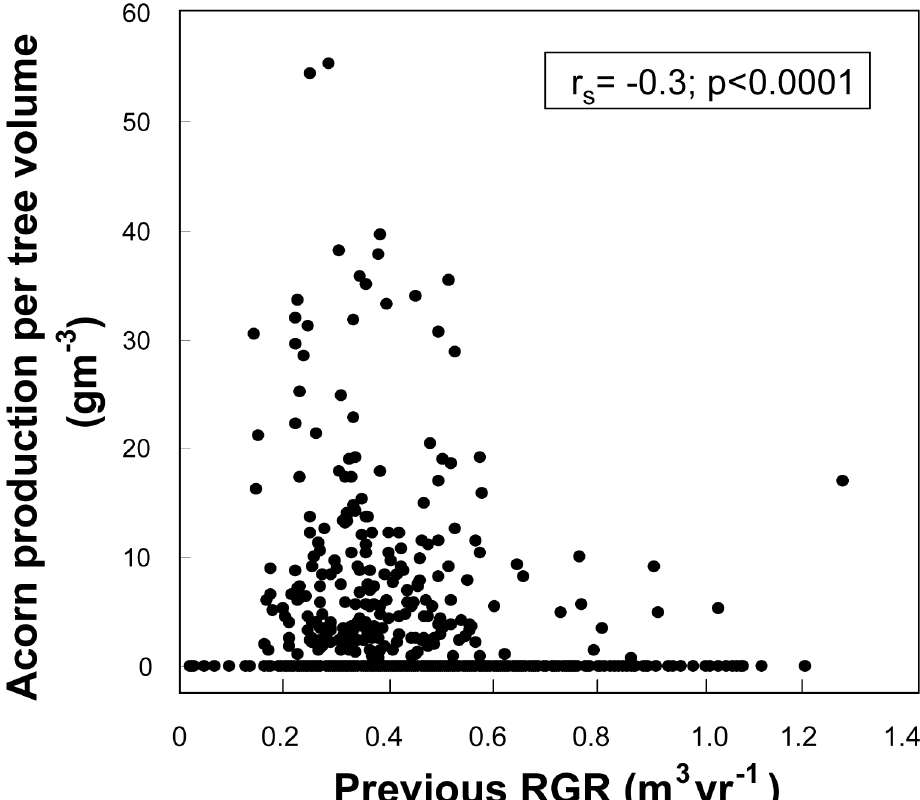
Fig. 5. Relationship between current acorn production per tree volume and previous relative growth rate in canopy volume (2002–2004) (n =